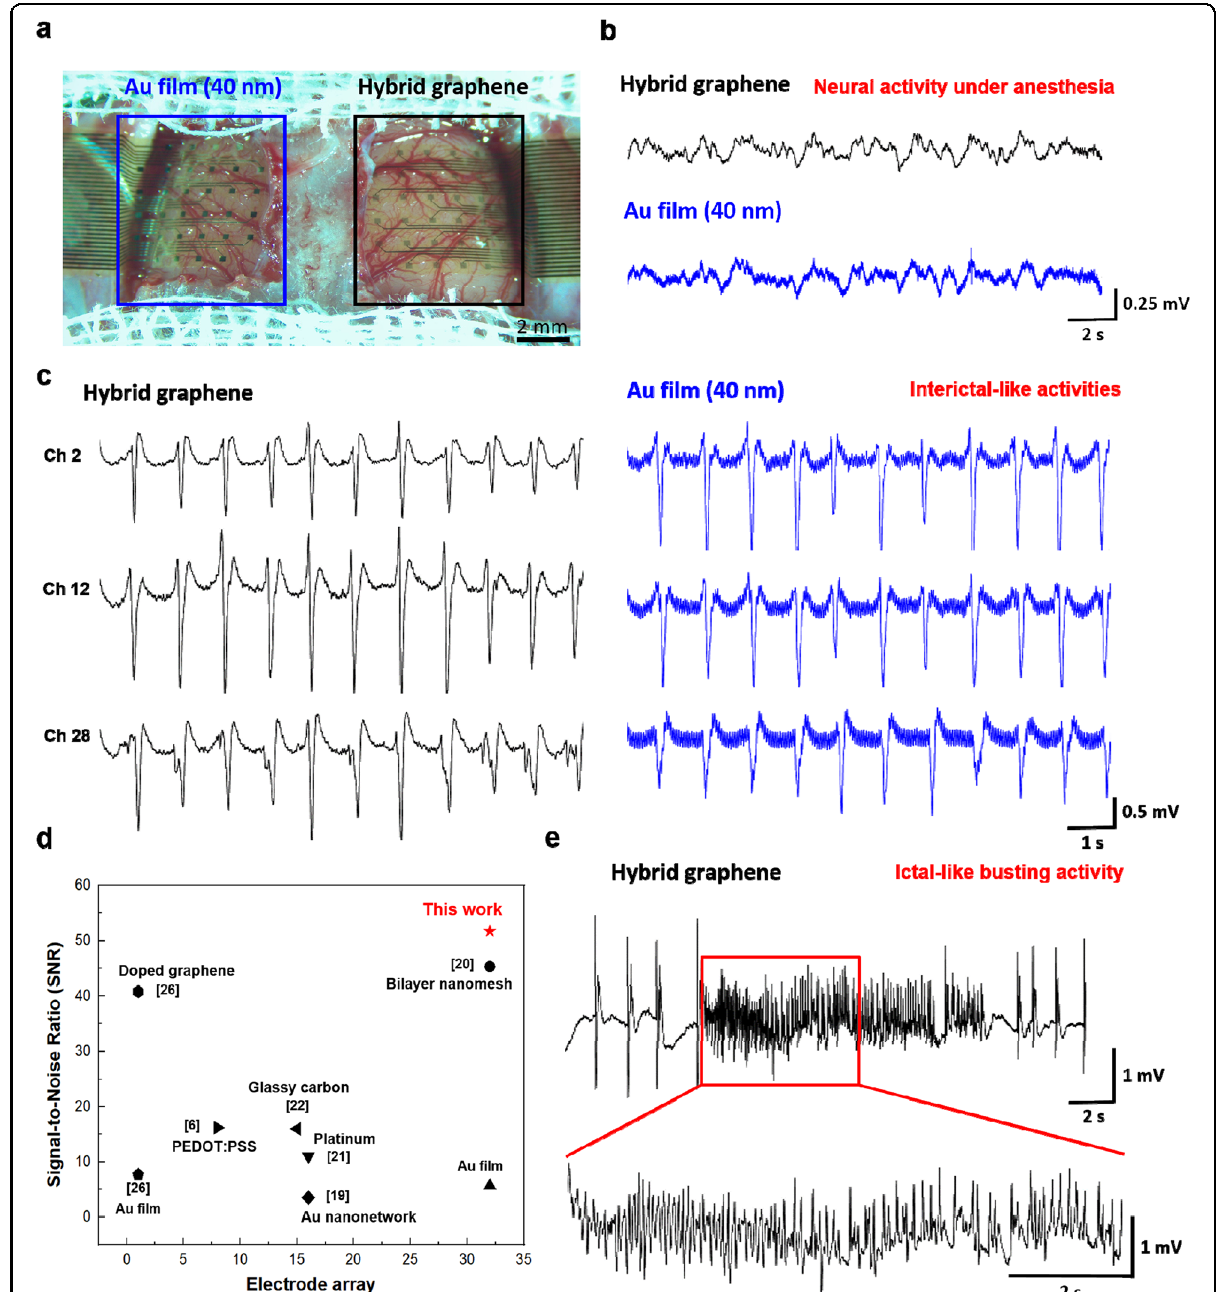
Fig. 3 In vivo multichannel recording of neuronal activities in rats. a Photograph of the 32-ch Au electrode array and hybrid graphene electrode array placed on the somatosensory system. b Neural activity under anesthesia. c Interictal-like activities recorded by both electrode types placed on the same hemisphere. d Comparison of the signal-to-noise ratio (SNR) of the hybrid graphene electrodes with SNRs from electrodes in previous studies. The hybrid electrode shows a higher SNR. e Ictal-like busting activity recorded by the hybrid graphene electrode after topical application of